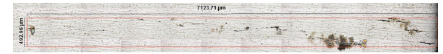
Figure 3: Stepwise cracks in thecrosssection of theAPI 5L B sample exposed to solution 177-A.